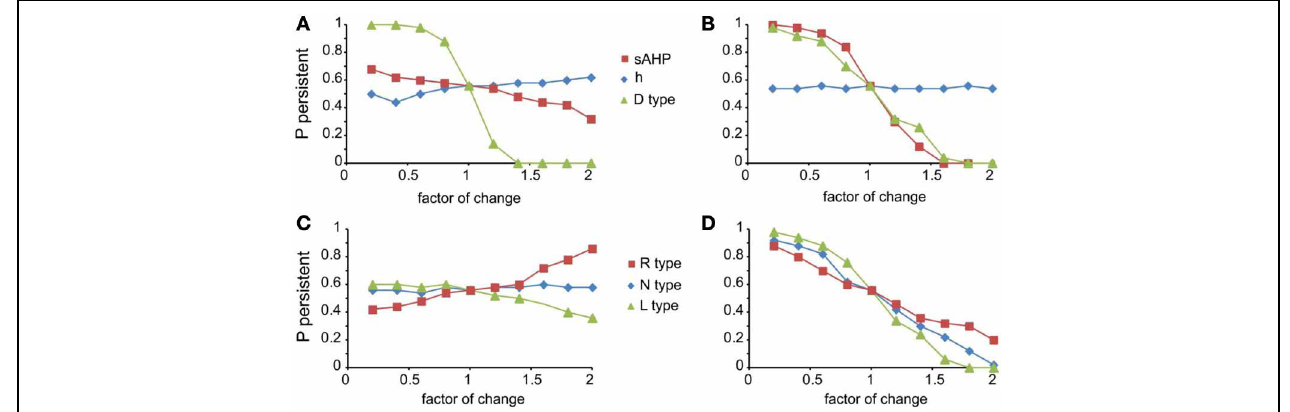
FIGURE 5 | Modulation of persistent activity by intrinsic conductances is location-specific. (A). Diagram showing the probability of induction when multiplying the dendritic conductance of D type, h channels and the channels that mediate the sAHP, by a factor of 0.2–2 with a step of 0.2. (B) Same as in (A) when